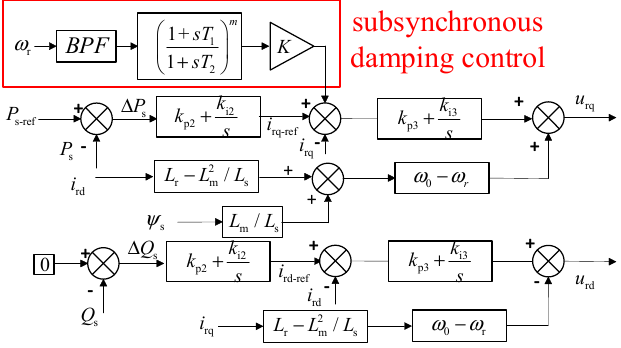
Figure 2. Control diagram of rotor-side converter (RSC).